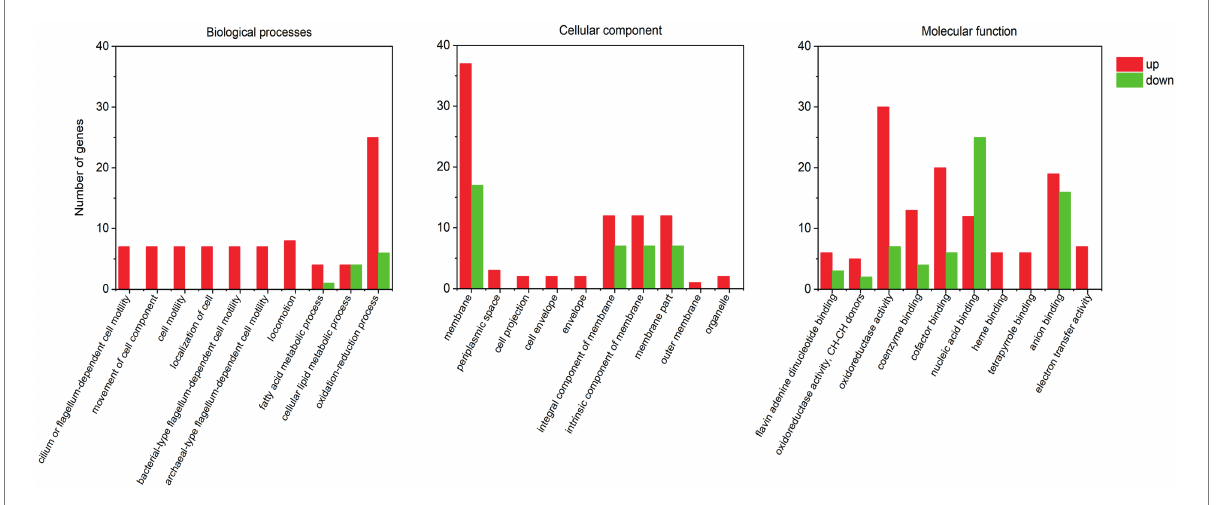
FIGURE 5 GO enrichment analysis of differently expressed